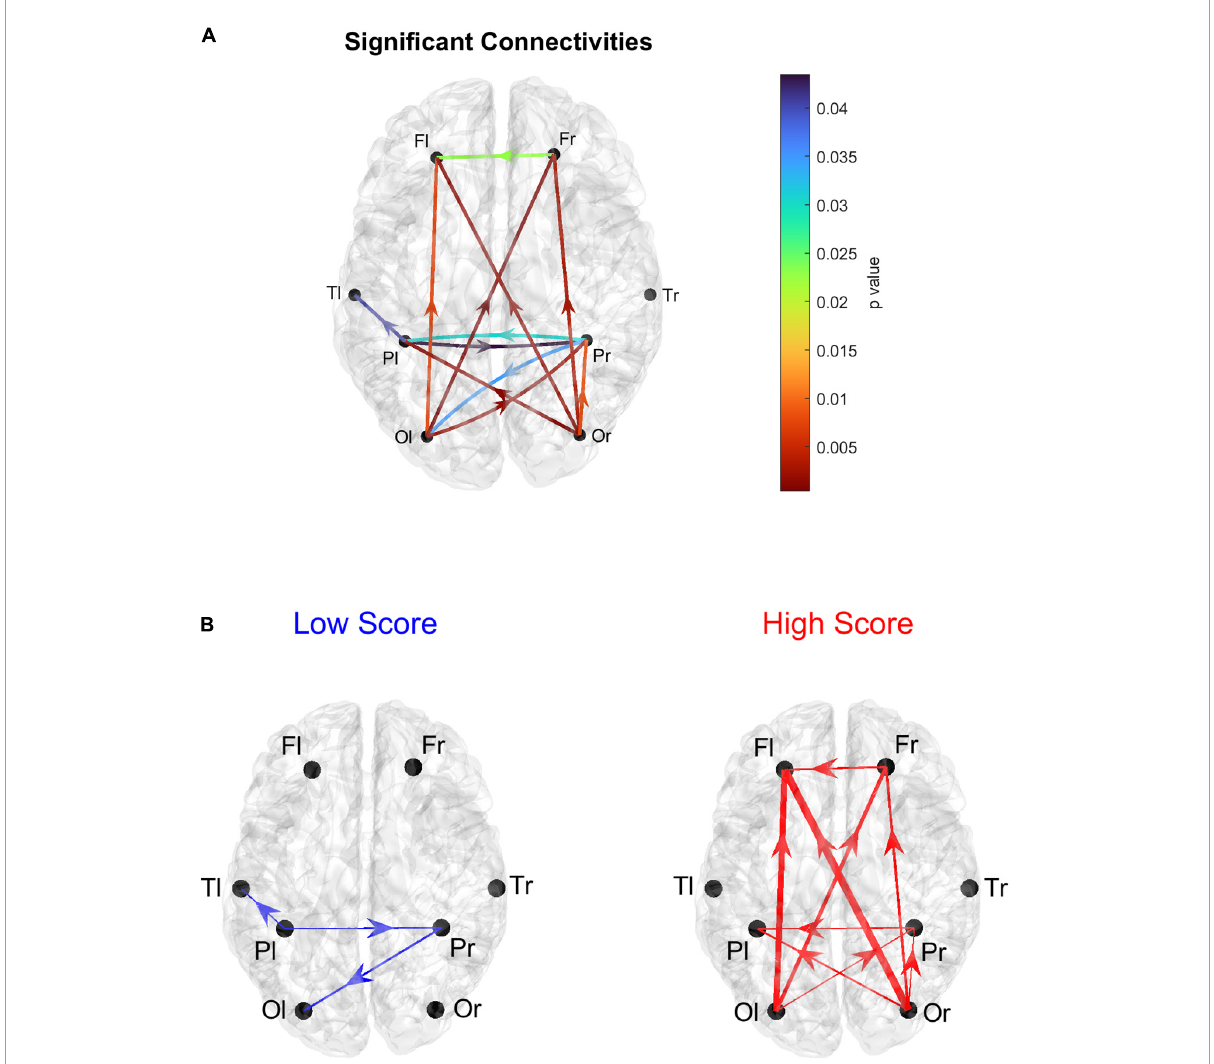
FIGURE5 Representation of the connections linking the eight lobes of the brain, Frontal (F), Parietal (P), Temporal (T), and Occipital (O), considering separately the right (r) and left (l) hemispheres. Only the connections that exhibited a statistically significant difference between the two groups ( p ≤ 0.05, uncorrected) are represented. The upper panel (A) shows the p -values of the significantly different connections. The lower panels (B) represent the differences in connectivity strength: the blue diagram (Low > High) shows the connection differences for those connections that resulted significantly stronger in the Low AQ score Group compared to the High AQ score Group; the red diagram (High > Low) shows the connection differences for those connections that resulted significantly stronger in the High AQ score Group compared to the Low AQ score Group. The thickness of each link varies according to the value of the connection difference. Three levels of thickness are adopted, with a larger thickness indicating a larger connectivity